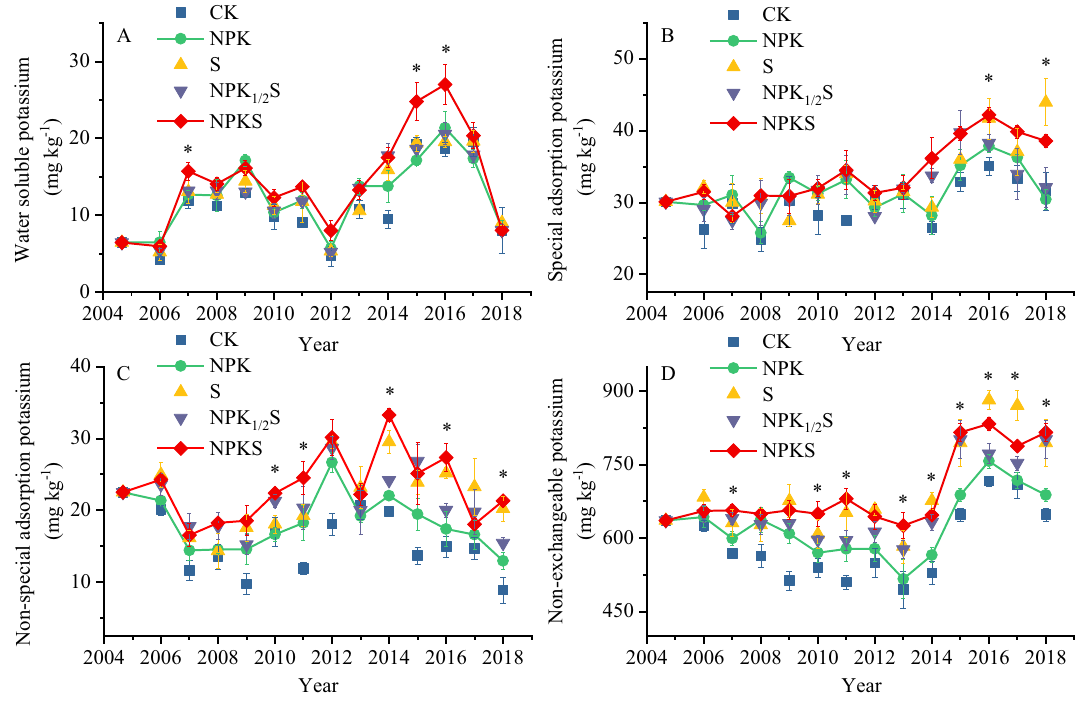
Figure 2. Dynamics of water soluble potassium ( A ), special adsorption potassium ( B ), non-special adsorption potassium ( C ), and non-exchangeable potassium ( D ) from 2005 to 2018. [CK, no fertilization; NPK, mineral fertilizing; S, straw 6000 kg h m −2 ; NPKS, NPK with straw 6000 kg h m −2 . The significance levels between NPKS and NPK are given (* p < 0.05)].